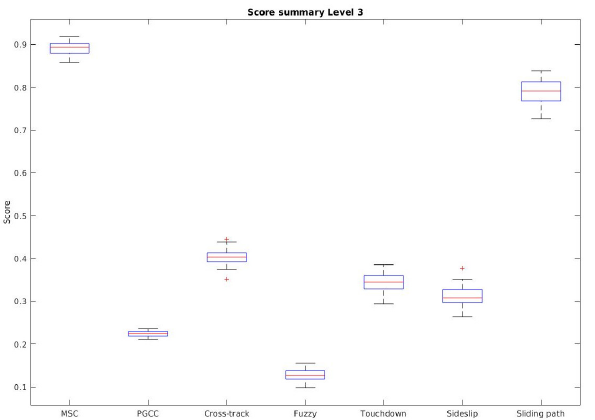
Figure 21. Score summary comparison between the different methods, taking the results of [14], using a box